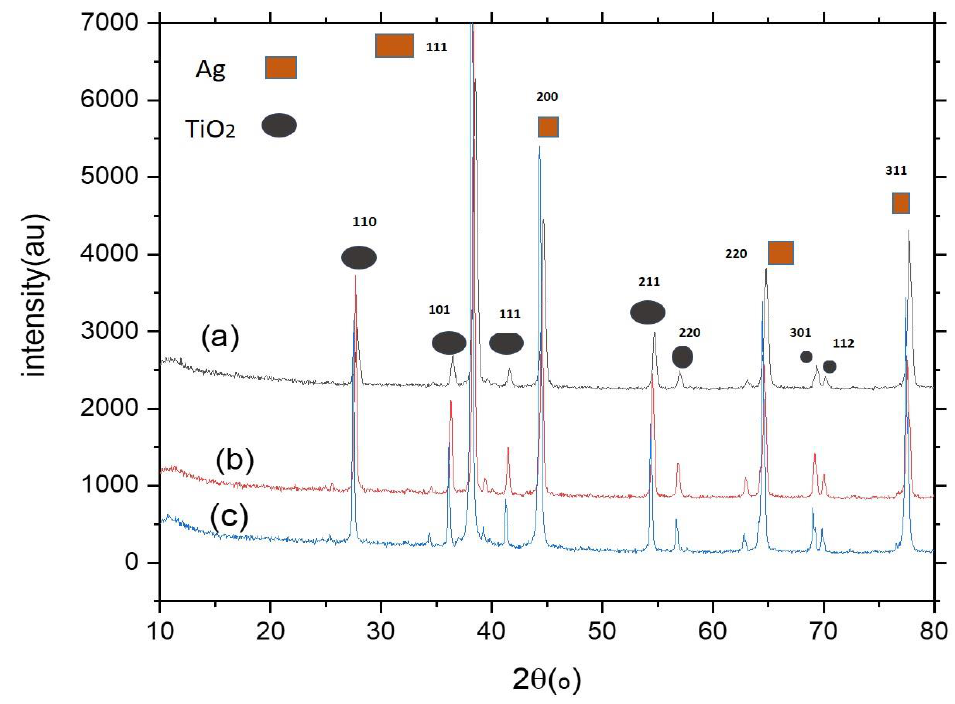
Figure 3. ( a ) XRD of 0.01 Ag/TiO 2 composite. ( b ) XRD of 0.1 Ag/TiO 2 composite. ( c ) XRD of 0.5 Ag/TiO 2 composite.